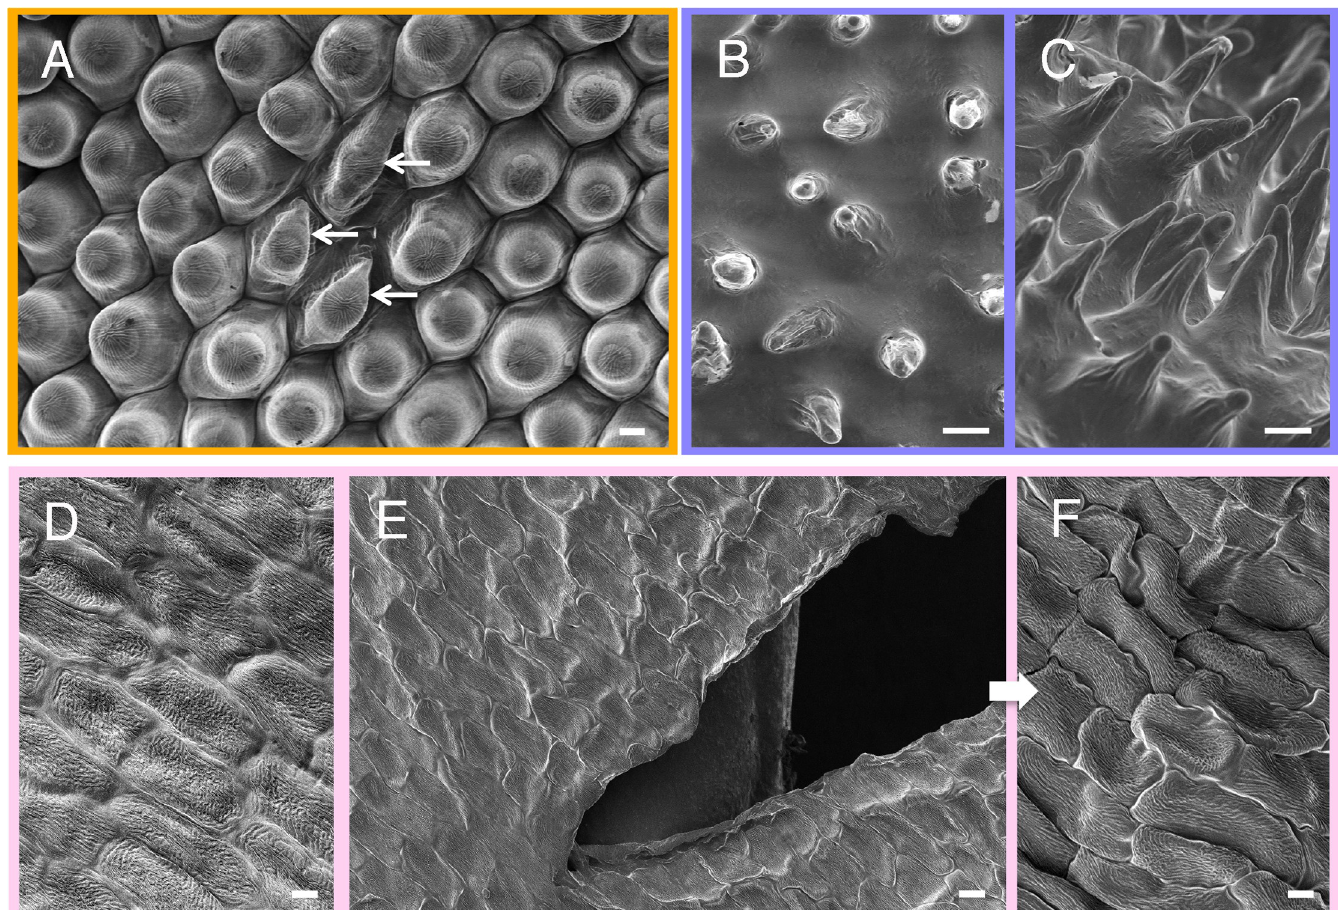
Fig 2. SEM images showing morphological variations in specimens prepared using the NanoSuit method. (A) Image demonstrating that some cells (indicated by arrows) appear to have collapsed on the surface of the petal. On the same petal, some areas (B) secrete a large volume of the natural surface substances, whereas other areas (C) have a small amount of the substances on the surface. (D) Image of the healthy petal surface. (E) Image after specimen was cut with a scalpel to create a wound on the surface. (F) Image of the changed structure after wounding. SEM images were taken by 300x (E), 500x (A), or 1,000x (B–D, F) with acceleration voltage of 1.0 kV at working distances of 7.3 mm (A), 6.9 mm (B), 7.8 mm (C), 7.1 mm (D), 10.1 mm (E), or 10.2 mm (F) under vacuum conditions of 1.6 − 3 Pa (A), 1.5 − 3 Pa (B), 1.4 − 3 Pa (C), 1.6 − 3 Pa (D), 1.3 − 3 Pa (E), or 5.8 − 4 Pa (F). Scale bars are (A, B, C, D, F) 10 μ m, (E) 20 μ m.